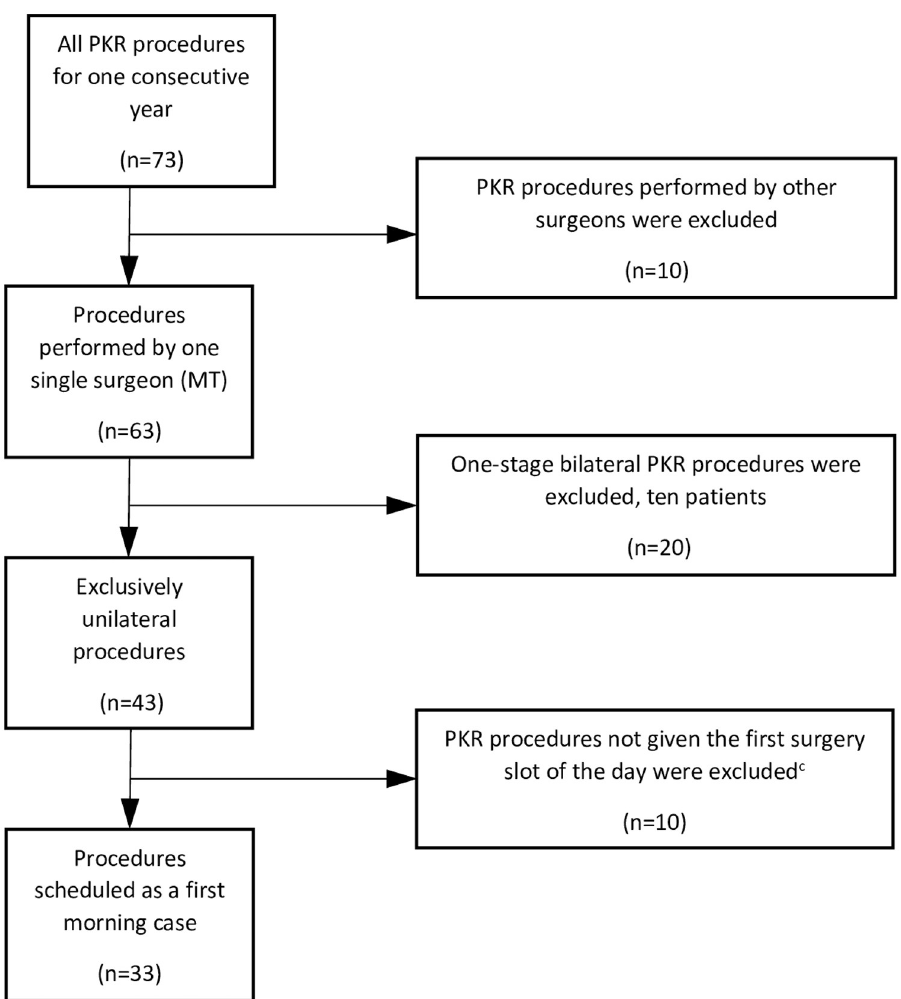
Fig 1. Flowchart of all the PKR procedures. a performed for one consecutive year at Trelleborg hospital b , and the path for inclusion in this interventional study. a They were all diagnosed either as antero-medial osteoarthritis or osteonecrosis of the knee, no lateral procedures were performed during this timeframe. b A public hospital within Region Sk å ne, the southernmost county council of Sweden. c The first morning slots were filled continuously as the patients were scheduled for surgery. When all slots had been taken within one week, any additional PKR cases were assigned to surgery later in the day the same week. The operation scheduling was put together on a weekly basis, in a strict chronological order, by a team of nurses and with no insight of the surgeon in question. (Prior to surgery, no preselection was made as regarded patient characteristics–everyone was considered eligible for inclusion).